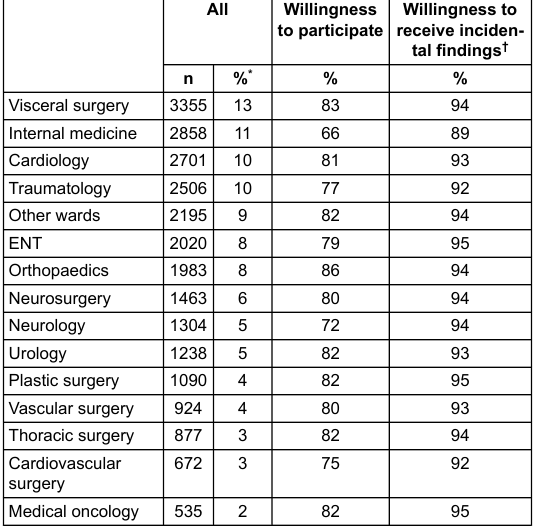
Table S1: Distribution of the 25 721 patients, according to the ward where they were contacted.